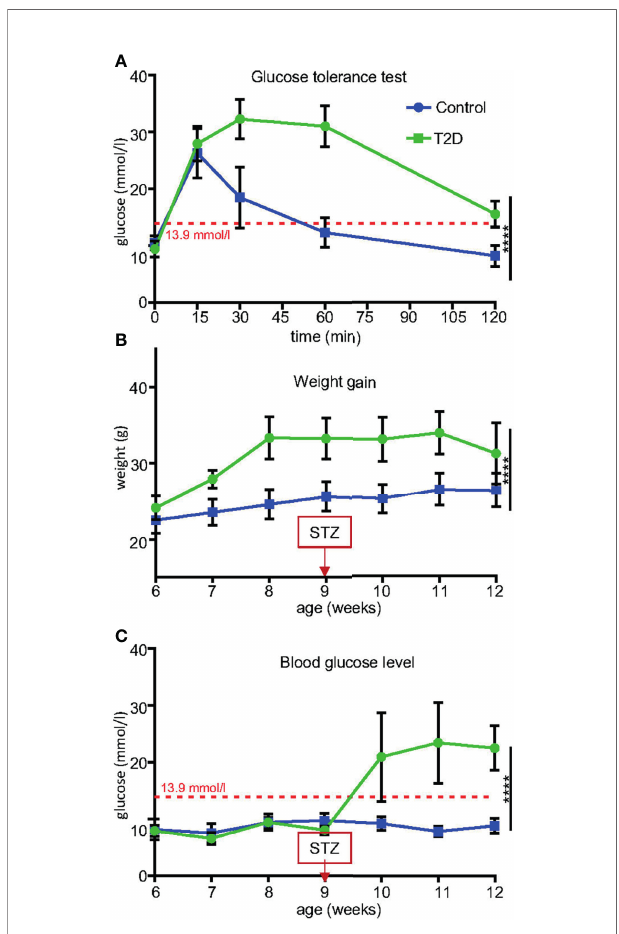
FIGURE 2 | Temporal changes induced in T2D males before mating. (A) After 8 weeks of HFD, all males were glucose intolerant compared to control males fed by standard diet. (B) Body weight trajectories in T2D males and control males. Note decreased weight gain starting week 11 due to worsening diabetes (hyperglycemia). (C) Blood glucose levels signi fi cantly increased after a low dose of STZ treatment in combination with HFD, as measured using a glucometer in blood collected from the tail vein after 6-hr fast. Blood glucose levels maintained above 13.9 mmol/l are classi fi ed as diabetic (red broken line). Data are presented as the mean ± SD (n = 10 Control and 8 T2D mice). Differences between groups were tested by Two- Way ANOVA for repeated measures, showing signi fi cant interactions between time x treatment as repeated measures. ****P <